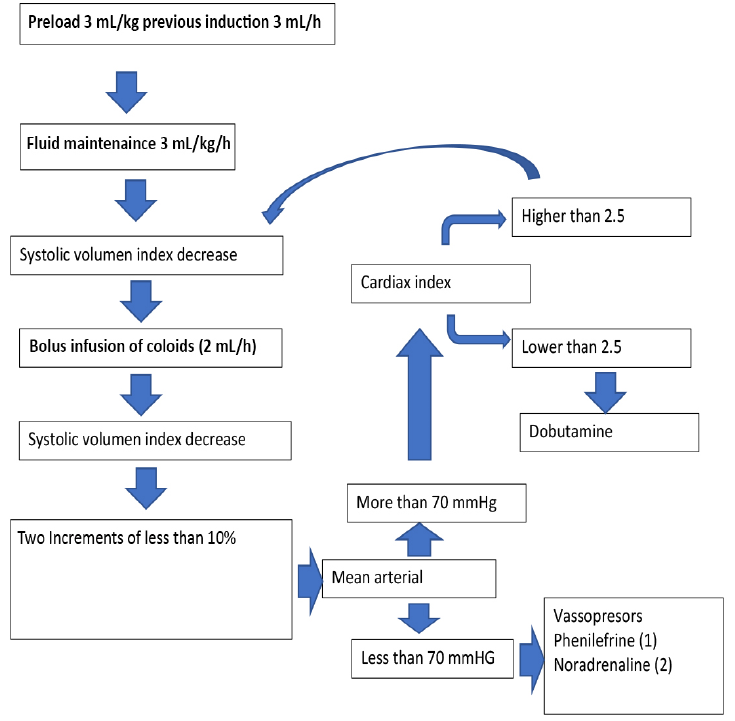
Figure 7. GDT algorithm.